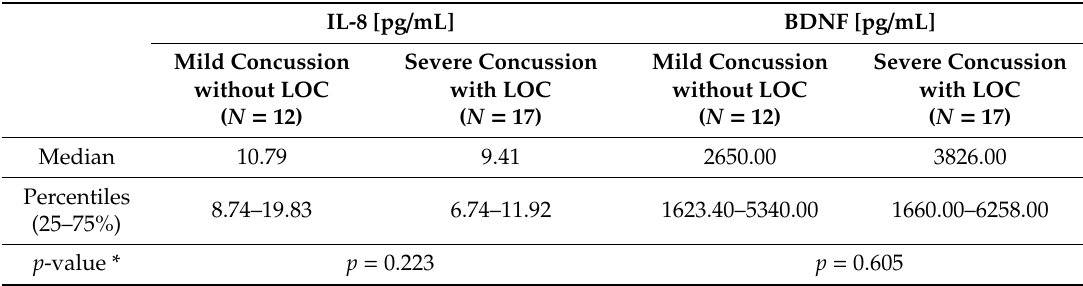
Table 2. BDNF and IL-8 concentration in children with mild head trauma: mild concussion without LOC vs. severe concussion with